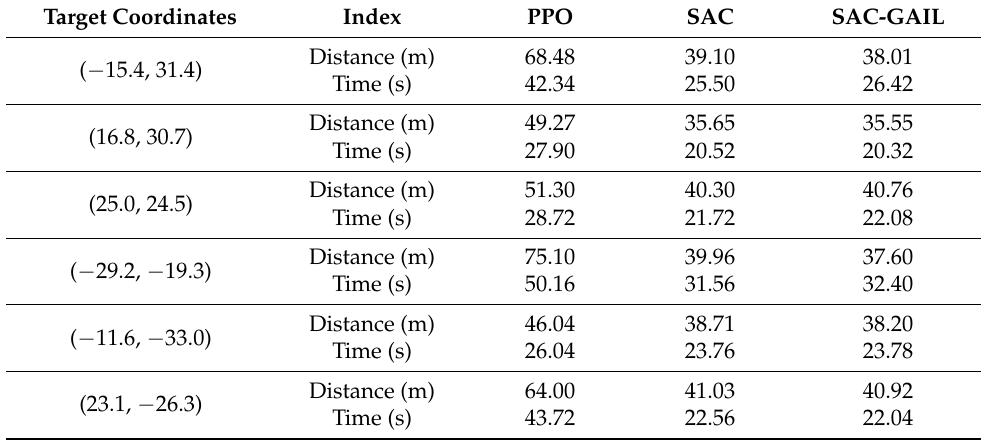
Figure 13. Six groups of actual planned trajectory routes. Table 8. Distance and time information of the trajectory planned. Target